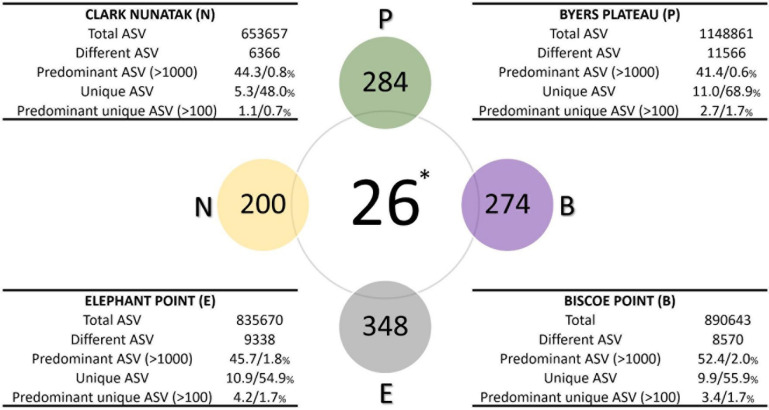
Diagram comparing the bacterial core communities. Colored spheres indicate the number of ASVs in at least 80% of top-stratum soils (core80) of each sampling location, while the central sphere (∗) indicates the Core90 (90% of all the top-stratum soils). For each location, in the tables are shown the number of total and different ASV of the bacterial community, and the percentages of the predominant ASV (at least 1000 copies), the unique ASV at each location (not present in other sampling areas), and the percentage of the predominant unique ASV (at least 100 copies), according to total and different ASV, respectively.